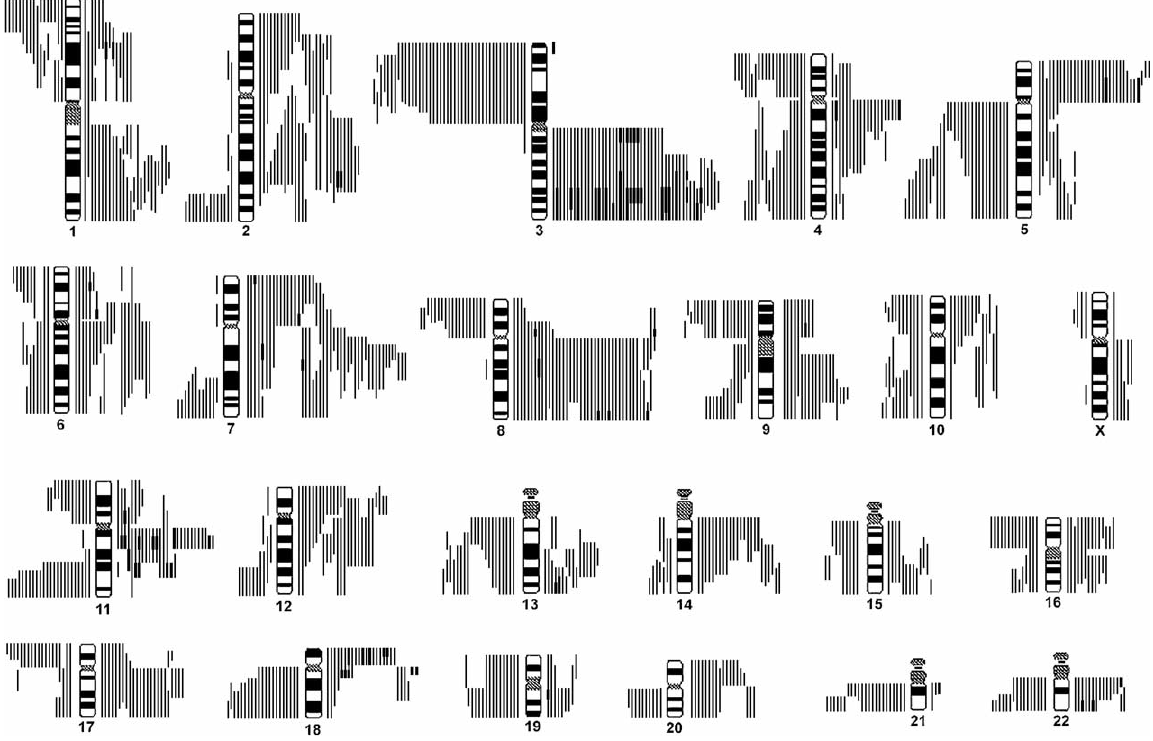
Fig. 2. Overview of CGH results of all 56 larynx and pharynx squamous cell carcinomas. Bars to the right of the ideograms represent gains and bars to the left represent losses. Amplifications are shown by bold bars.